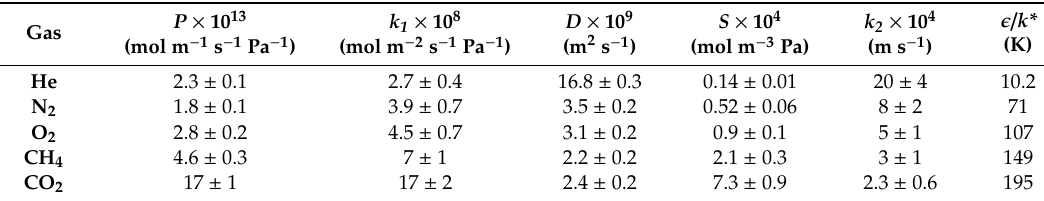
Table 1. Permeability P , sorption rate k 1 , di ff usivity D , solubility S , desorption rate k 2 , Lennard–Jones temperature (cid:15) / k. The transmembrane pressure was ∆ p = 1.013 × 10 5 Pa. The temperature was T = 293 K; Table 1 Permeability P , sorption rate k 1 , diffusivity D , solubility S , desorption rate k 2 , Lennard–Jones *data were taken from reference [13]. temperature ϵ / k. The transmembrane pressure was Δ p = 1.013 × 10 5 Pa. The temperature was T = 293 K; *data were taken from reference [13].